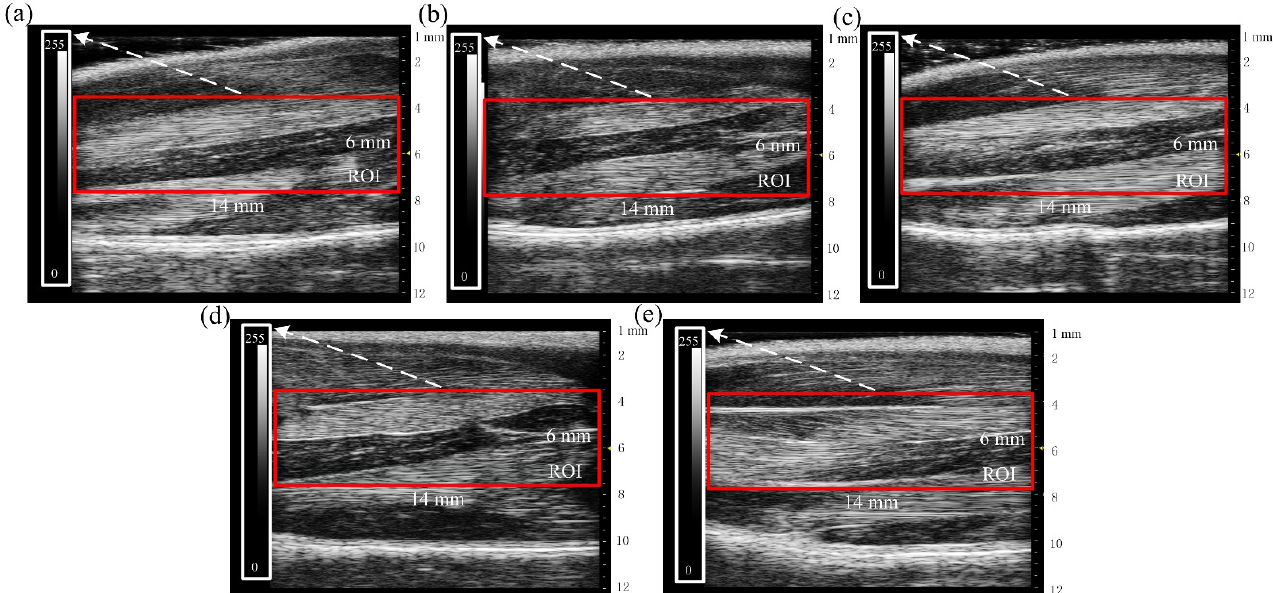
Figure 6. B-ultrasonic images of rats’ hind limbs in five groups on day 14. ( a ) B-ultrasonic image of the B group. ( b ) B-ultrasonic image of the SUC group. ( c ) B-ultrasonic image of the 50 UR group. ( d ) B-ultrasonic image of the 150 UR group. ( e ) B-ultrasonic image of the NC group. In the figure, the red rectangle is the region of interest (ROI), the white rectangle is the scale bar of the ROI, the yellow arrow represents the focus depth of array transducer. The red rectangle in Figure 6 was used as the region of interest (ROI). The grayscale mean value, variance value, ASM, ENT, and contrast were identified from ROIs to